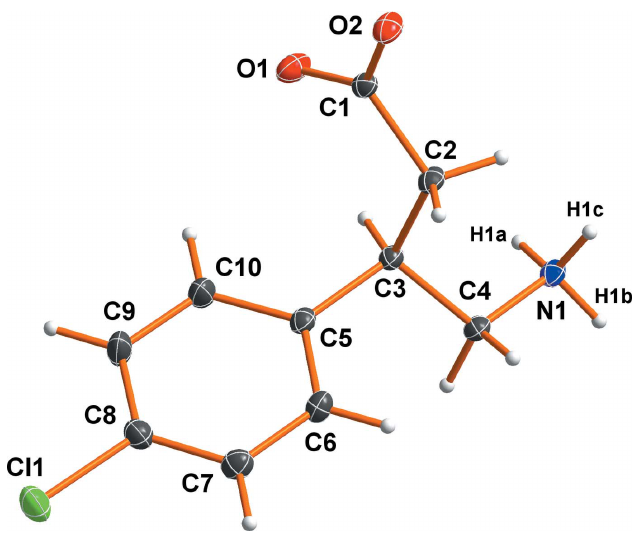
Figure 1 The molecular structure of ( R )-baclofen with displacement ellipsoids shown at the 50% probability level.